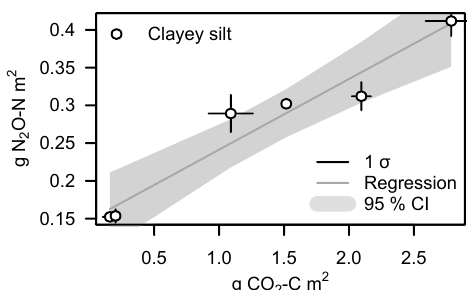
Figure 7. Regression between cumulated CO 2 emissions (gCm − 2 ) and the respective cumulated N 2 O + N 2 emissions (gNm − 2 ) from the clayey silt with WFPS > 35% during the period of aerobic headspace with their standard deviations and confidence interval (95%). If error bars are not visible, they are smaller than the sym- bols of the means. The proportional increase in CO 2 and the N gas species shows a good regression fit of R 2 = 0.93 ( p =